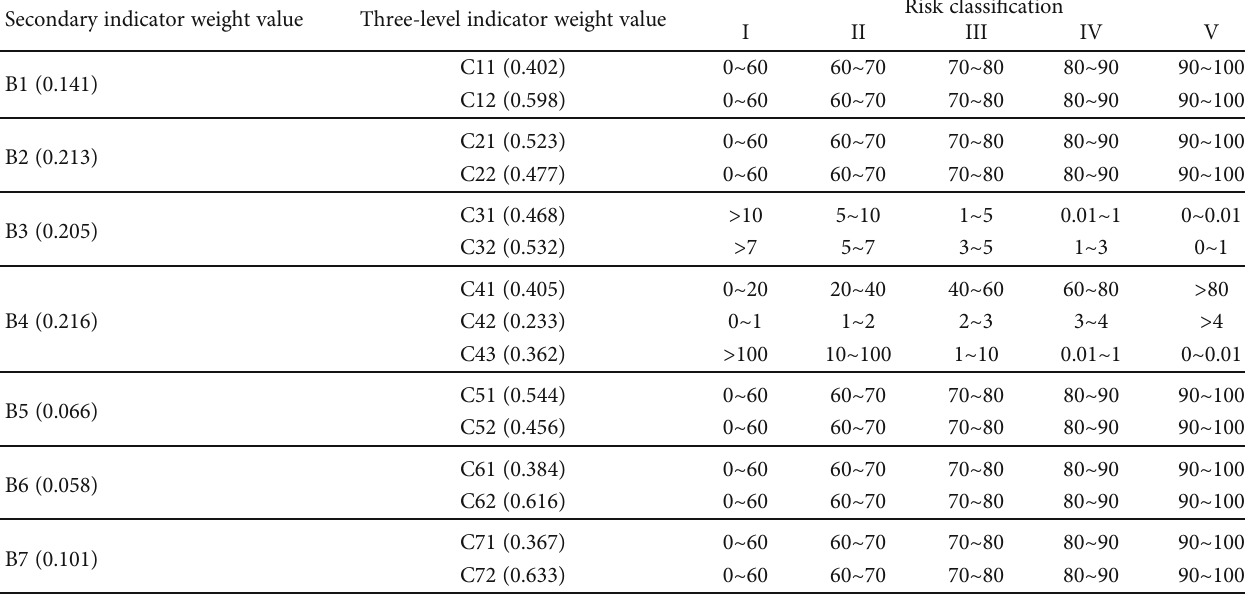
Table 1: Indicator weight and three-level indicator risk classi fi cation.